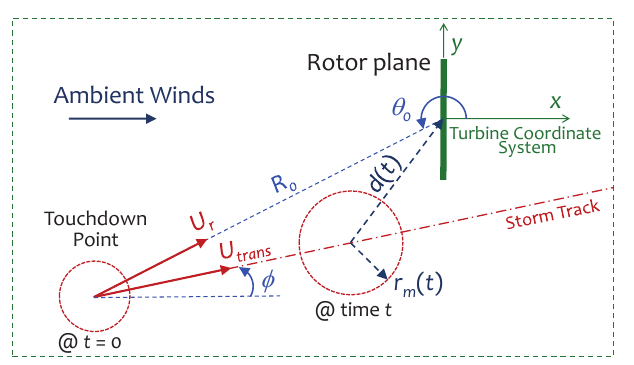
Figure 2. Downburst and wind turbine (plan